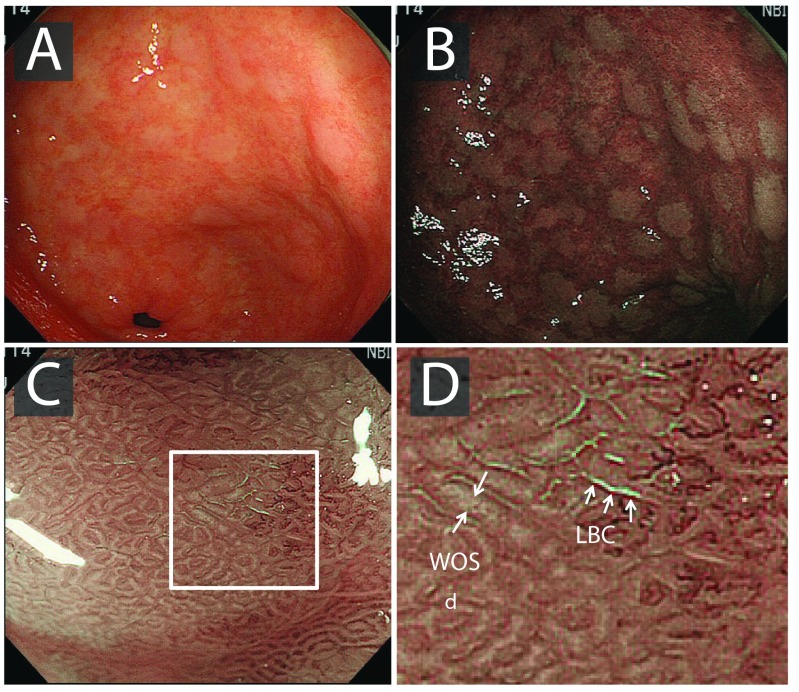
Endoscopic findings of gastric intestinal metaplasia.
A) White light endoscopy image, with gastric intestinal metaplasia clearly visible as pale whitish patches.
B) Narrow band imaging enhances mucosal contrast, highlighting patches of gastric intestinal metaplasia.
C) Magnification endoscopy demonstrates light-blue crests (LBCs) on the surface of the epithelium; in some cases, a white opaque substance (WOS) is seen in the intervening part of the crypt openings.
D) Corresponds with the white square in image
C. Images from
63.